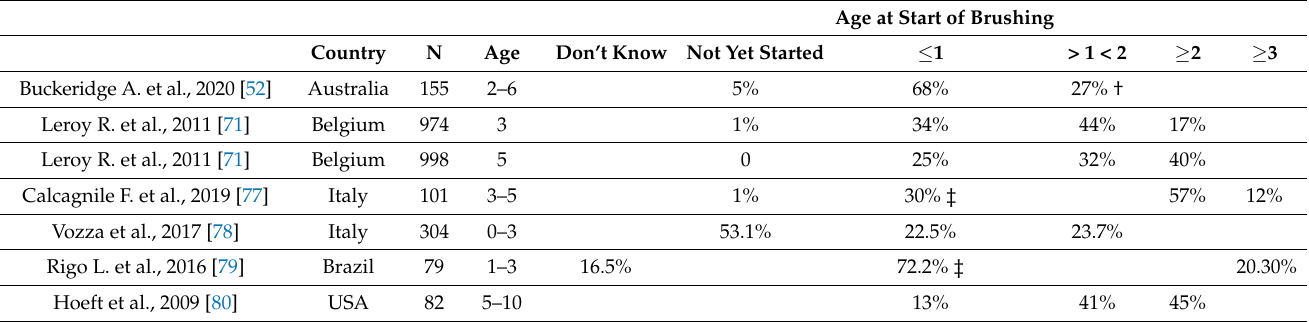
Table 4. Age at start of brushing in different population